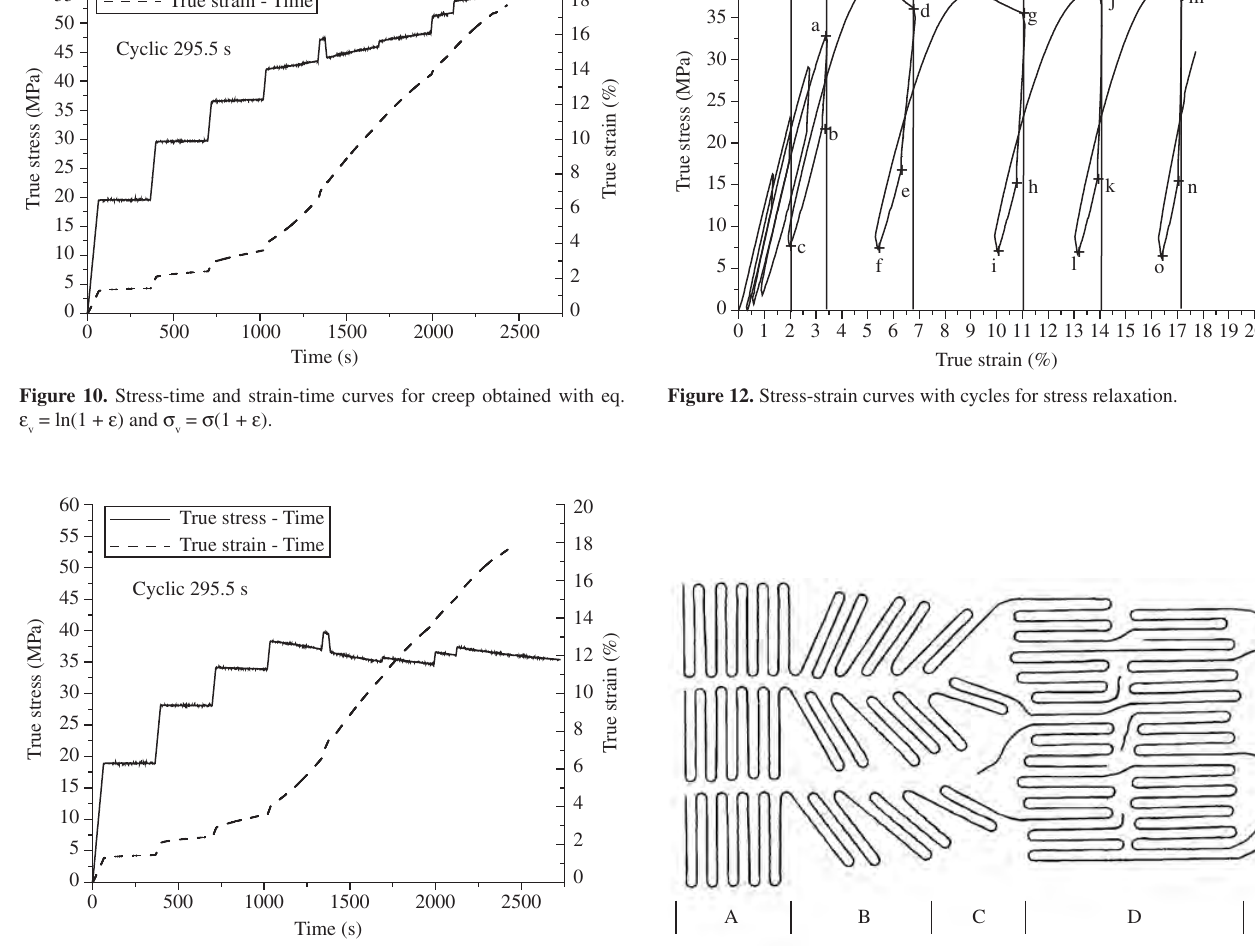
Figure 13. Schematic representation of a polymer at the molecular level